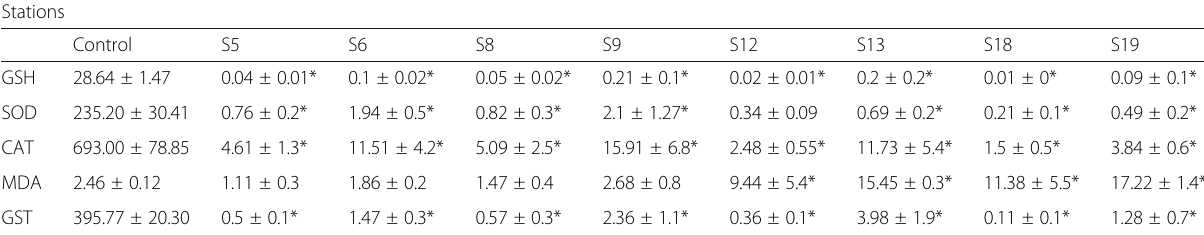
Table 5 Levels of antioxidant defense systems in earthworms collected from different stations of Ijegun ( n = 5) Stations Control